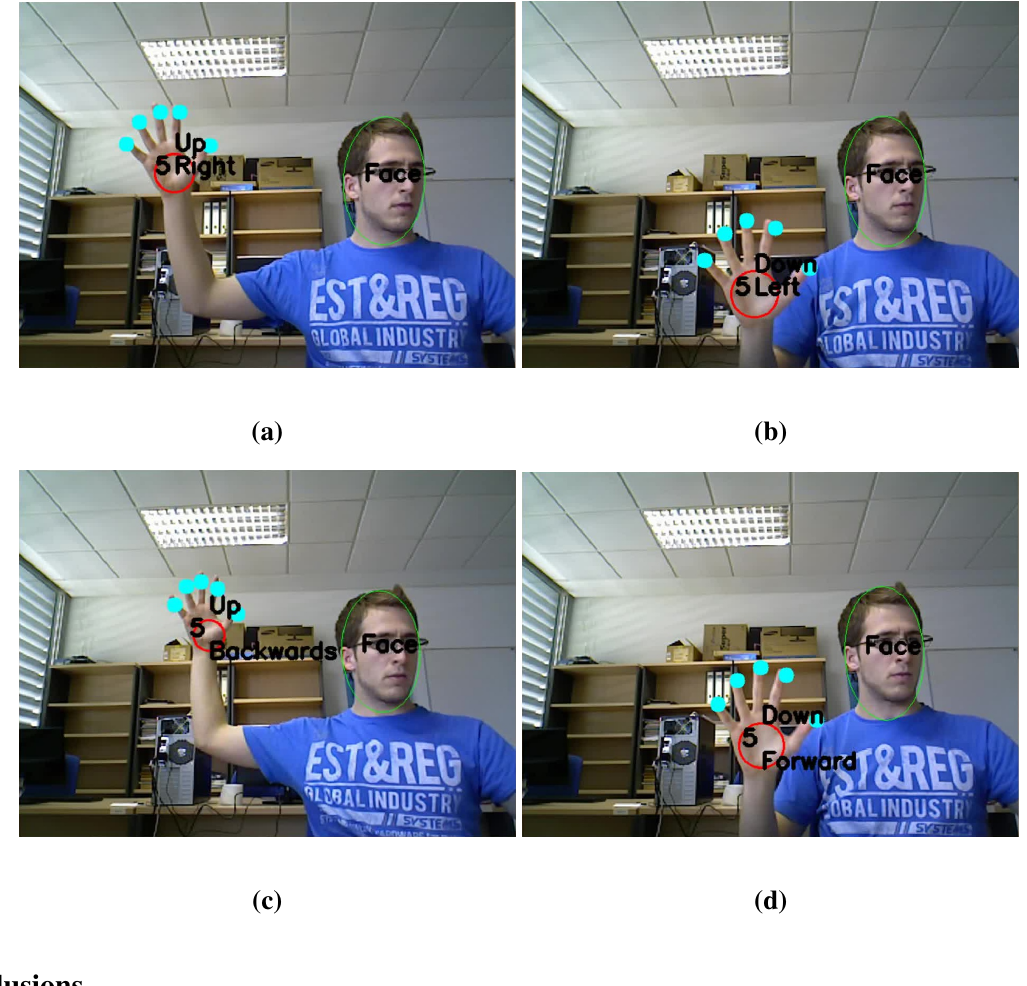
Figure 14. Several frames of the dynamic gesture recognition video demonstration: a) Up and right gestures; b) Down and left gestures; c) Up and backwards gestures; d) Down and forward